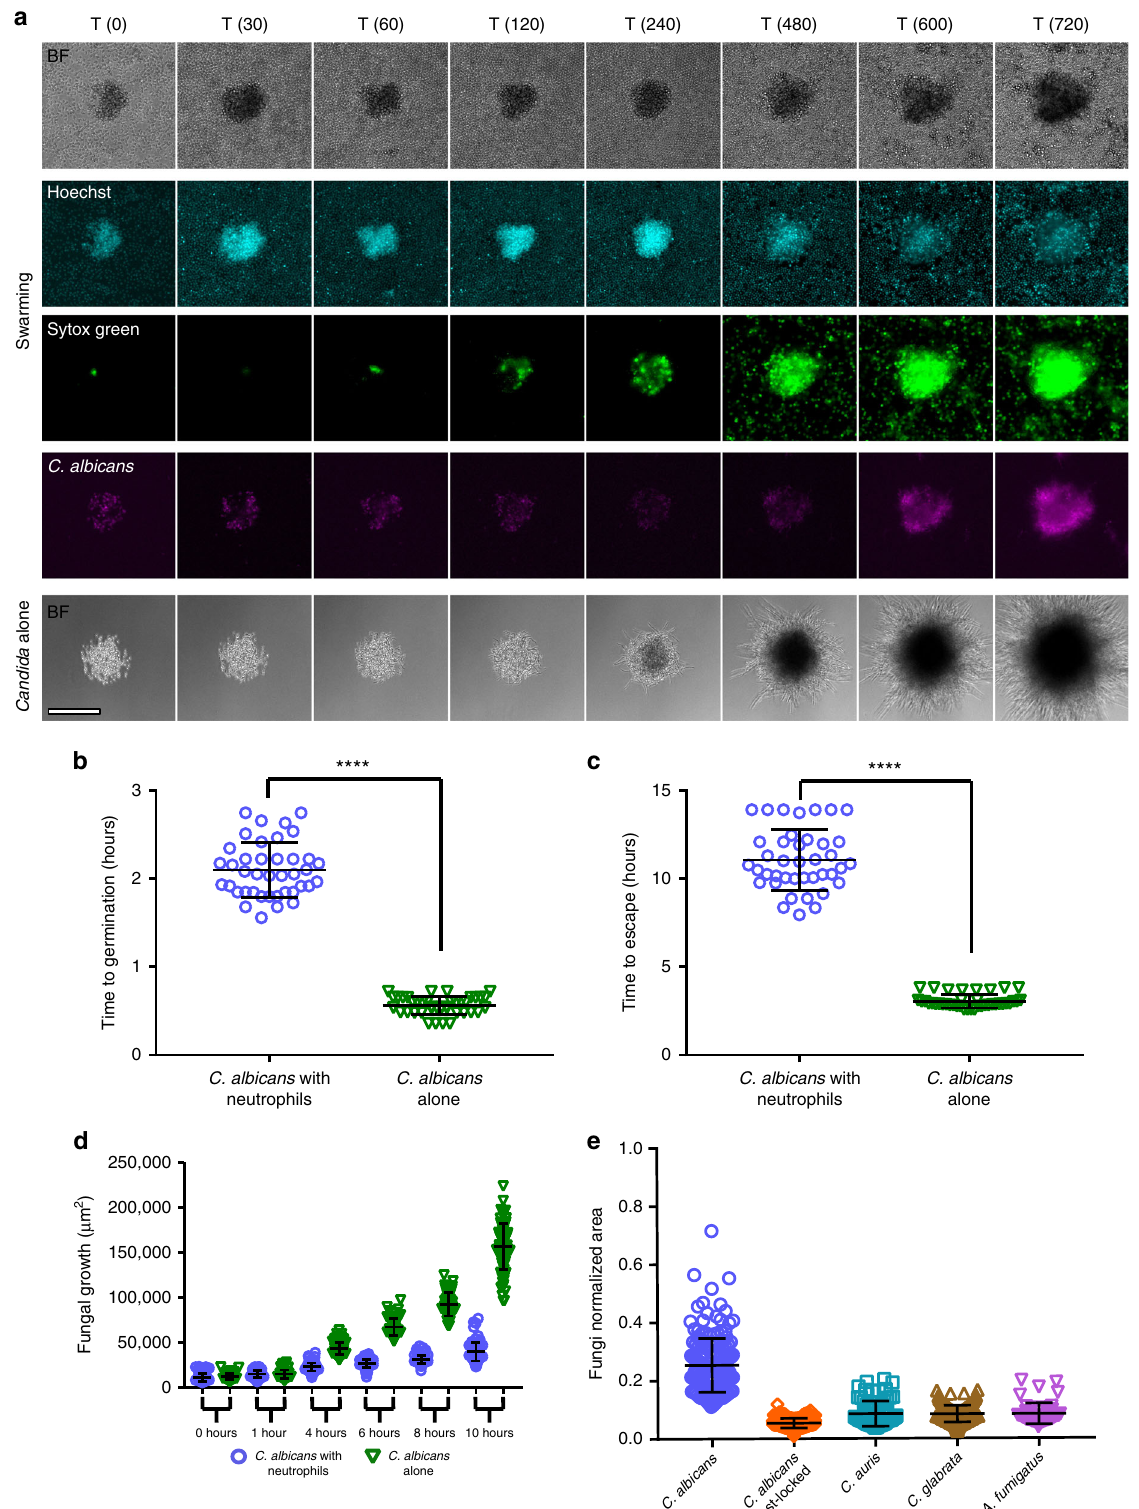
and C . glabrata do not produce hyphae, while C . albicans , which induces larger swarms, can switch from yeast to hyphae.